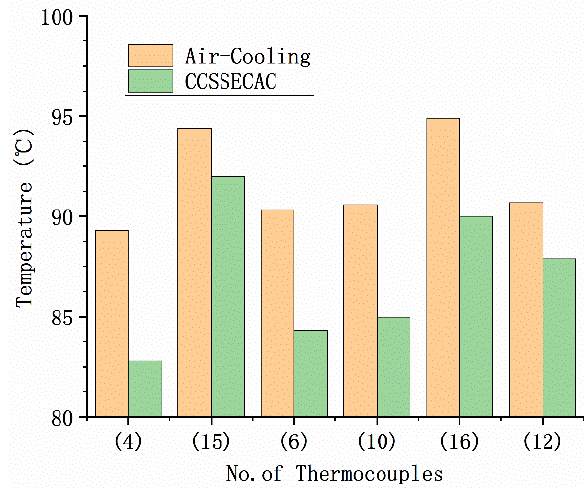
Figure 6. The temperatures at different positions.